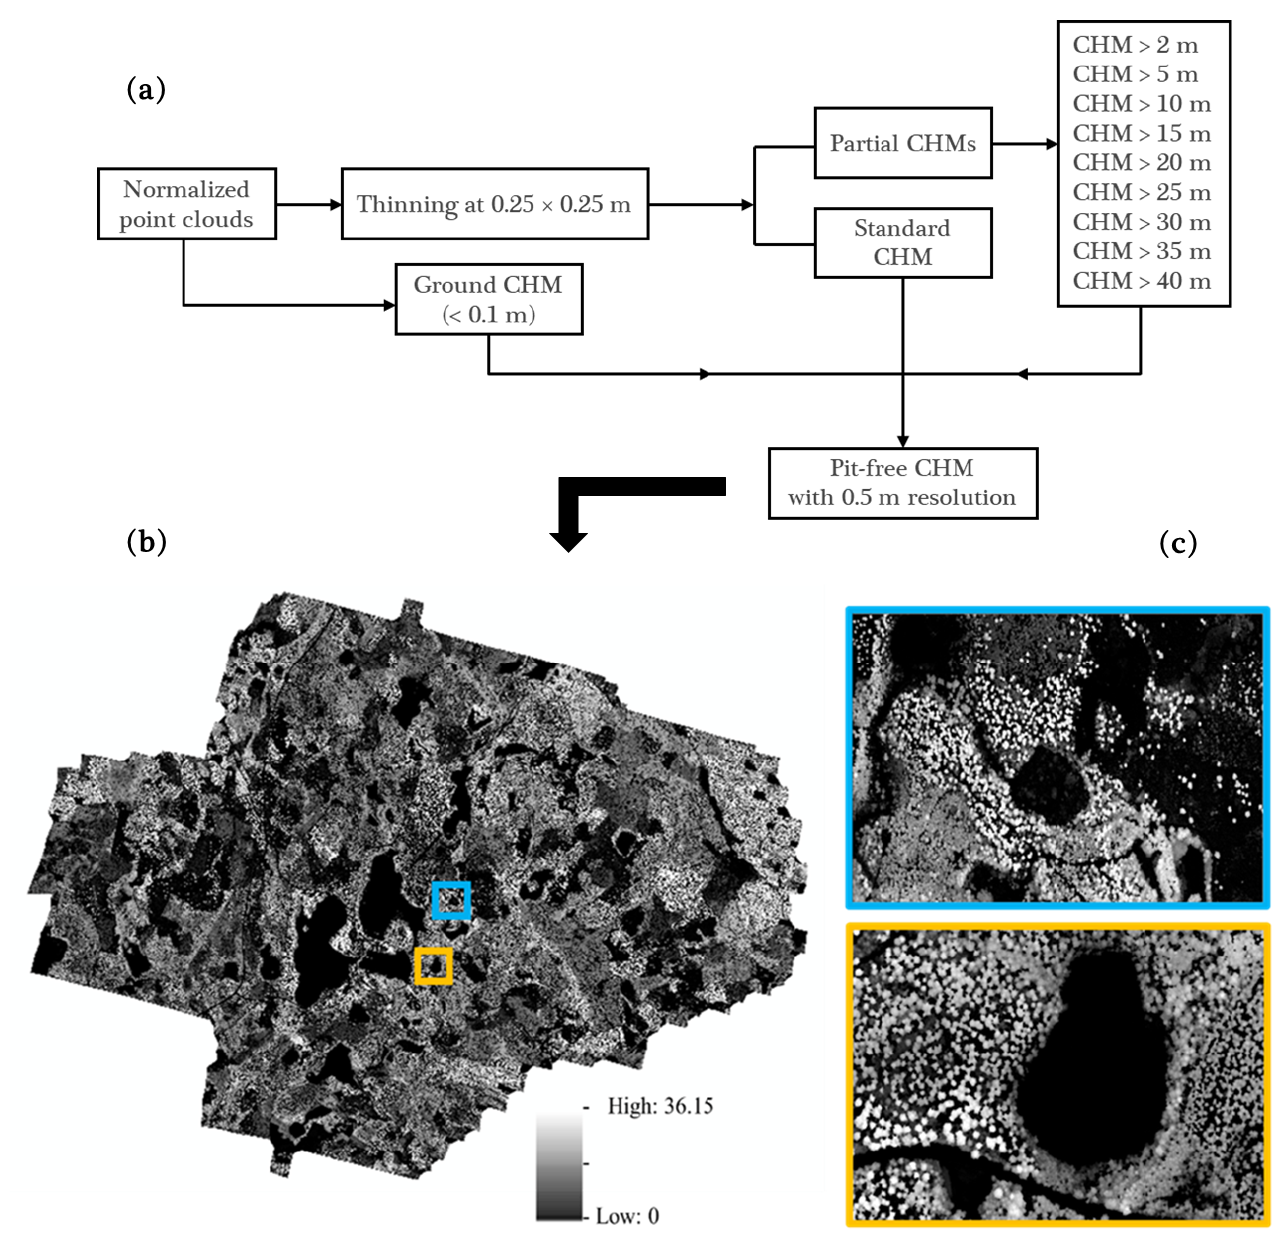
Figure 3. ( a ) Pit-free algorithm, ( b ) canopy height model (CHM) of the whole study area in T1 (2009), and ( c ) its zoomed-in views.